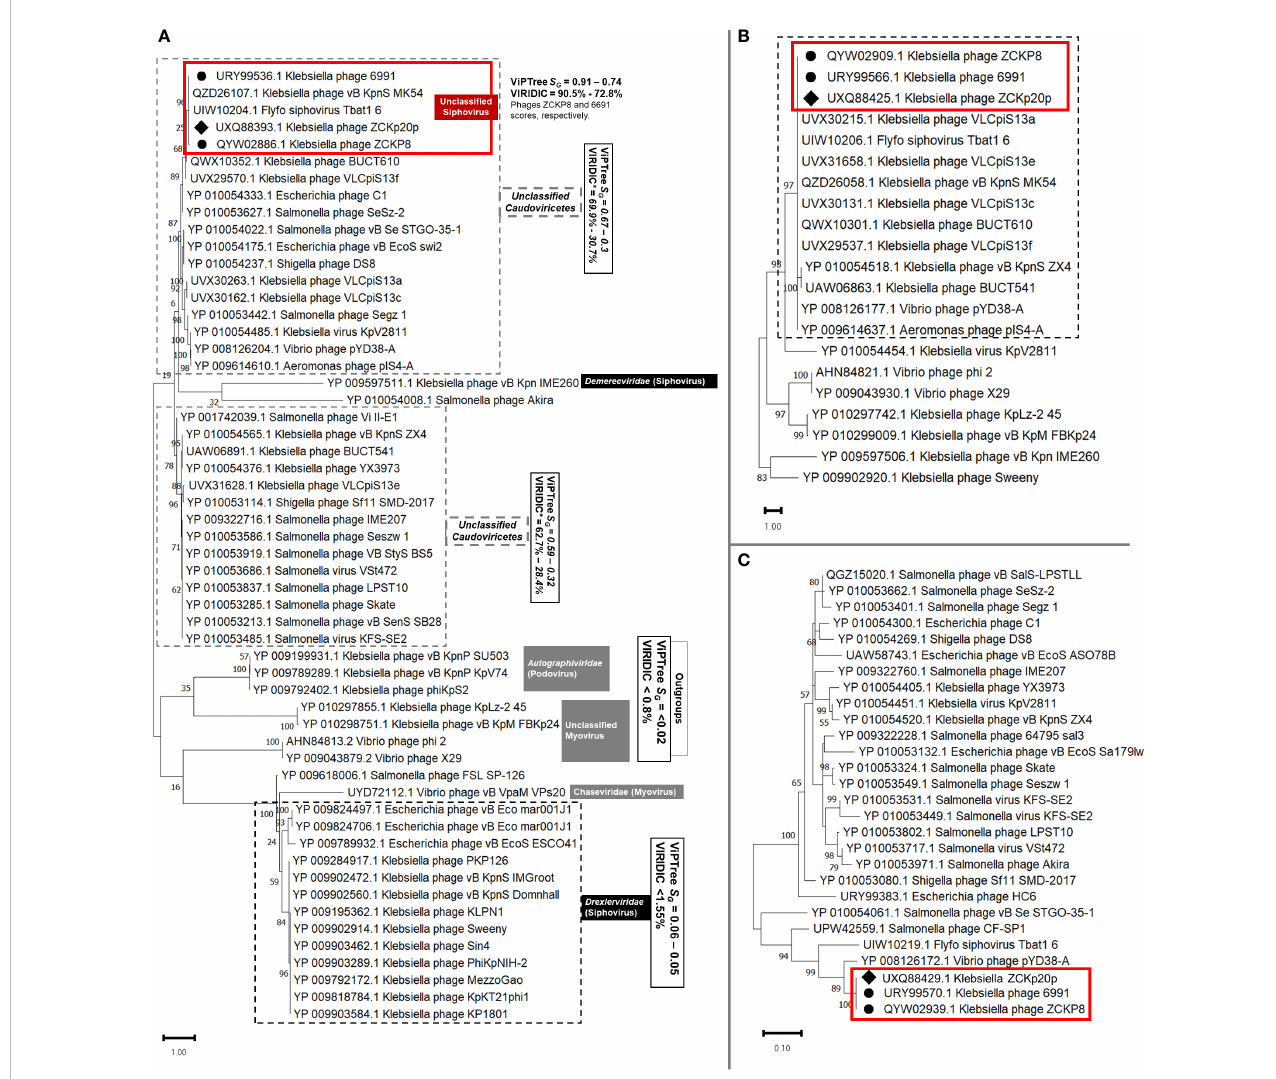
FIGURE 12 Viral conserved signature protein-based phylogenetic tree. (A) A phylogenetic tree for the evolutionary relatedness of the terminase large subunits of phage vB_Kpn_ZCKp20p to its corresponding proteins in other phages. (B) Phylogenetic tree of the major capsid protein of vB_Kpn_ZCKp20p and its orthologs in closely related phages. (C) Phylogenetic tree of the DNA polymerase III beta subunit of phage vB_Kpn_ZCKp20p and its orthologs in other phages. Phages included in the evolutionary analysis were chosen based on the closest relatives according to the proteomic tree and intergenomic similarity analysis. The phylogenetic distance was inferred by the Maximum likelihood method and supported with a bootstrap of 1000 replicates, and the trees were constructed by MEGA11. Phage vB_Kpn_ZCKp20p clusters were outlined in red based on the protein homology in both trees of the highest log likelihood (-12536.16, -5522.81 and -1839.71,